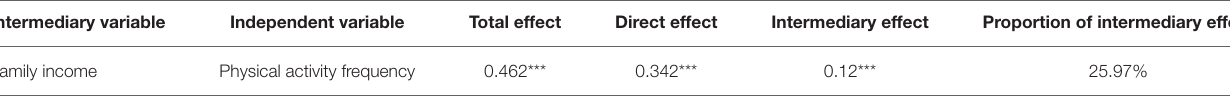
TABLE 3 | The intermediary effect of adolescent self-assessment and physical activity. Intermediary